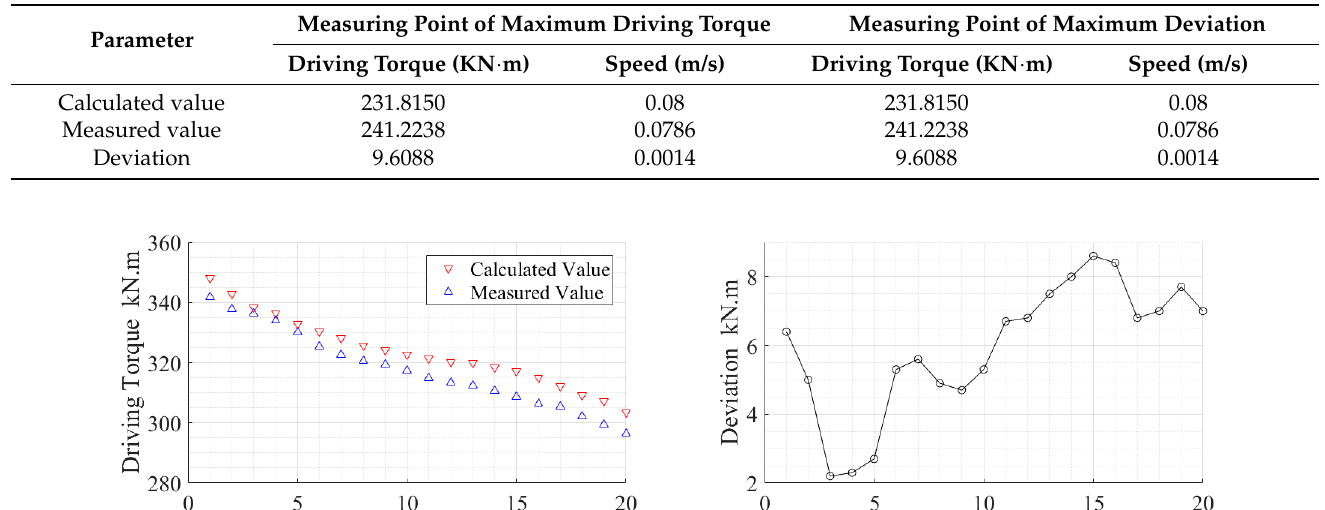
Figure 7. Experimental data of uniform motion, ( a ) Driving Torque of Calculation and Measuring, ( b ) Deviation Torque. Table 1. Comparison between experimental and calculated data of uniform motion.